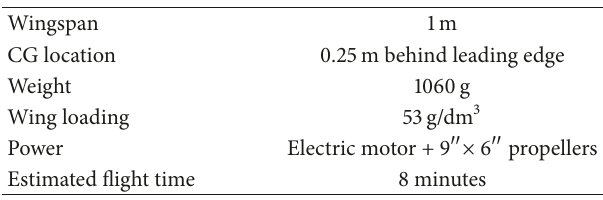
Table 2: Specifications of the FMW mini-UAV.